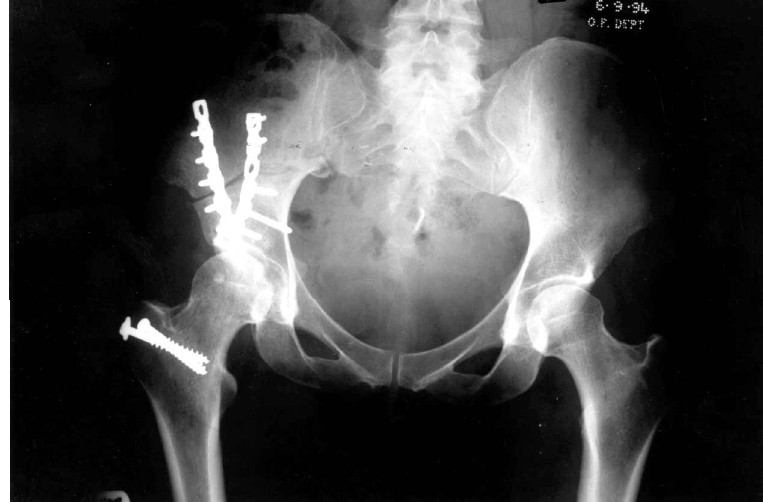
Figure 2. The immediate postoperative X-ray demonstrating the two osteotomies.